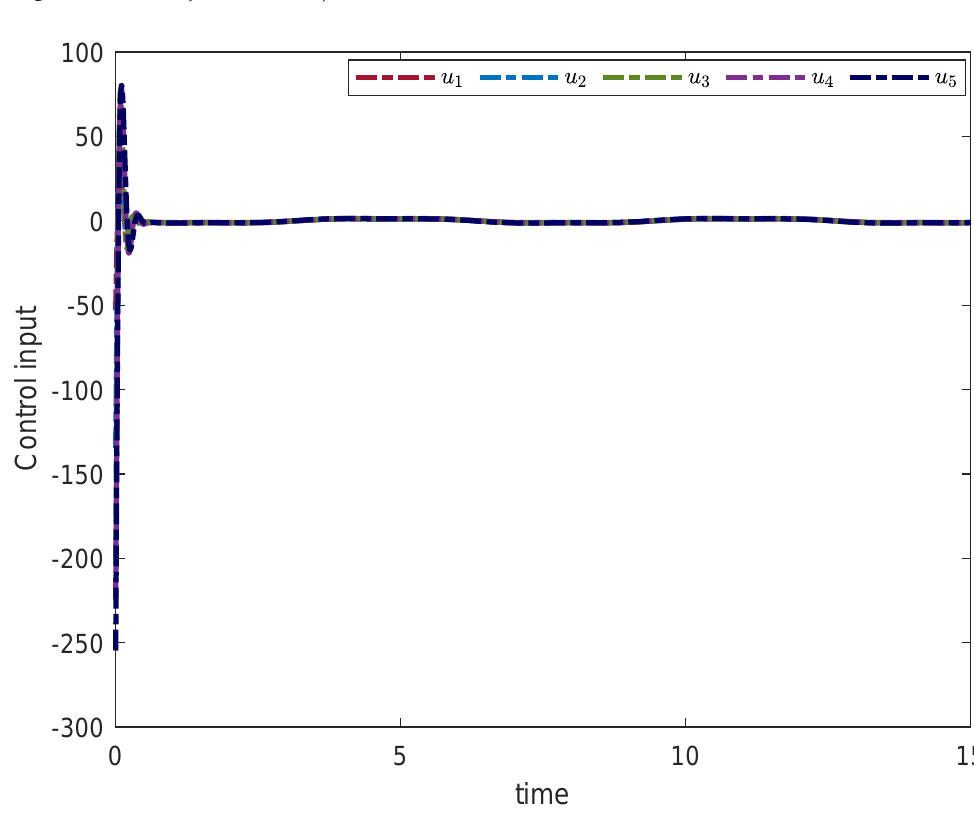
Figure 11. The trajectories of control input u i